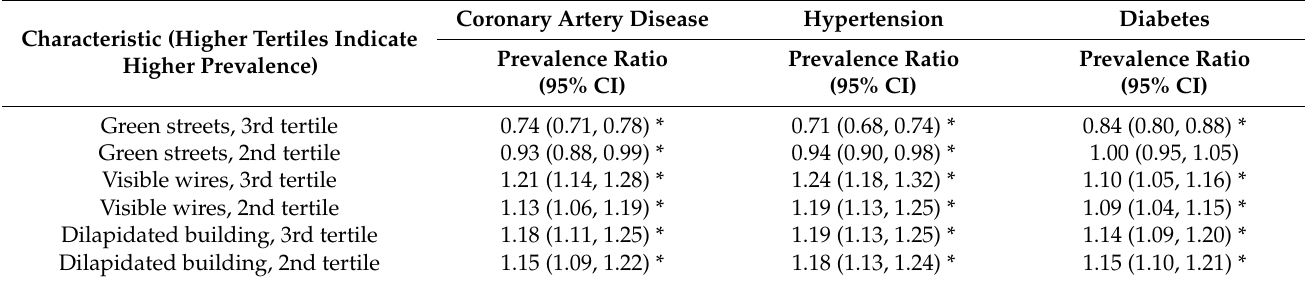
Table 2. Associations between Google Street View-derived built environment characteristics and coronary artery disease, hypertension, and diabetes (N =